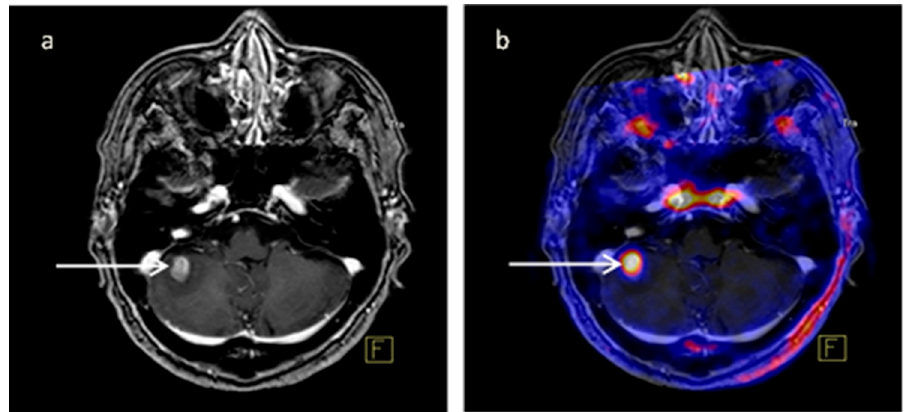
Figure 3. MRI-T1 post gadolinium sequence ( a ) and fused PET/MRI ( b ) images. Cerebellar metastatic lesion (arrows) 4 months after radiotherapy. Primary cancer site is breast. SUVmax, T/B, SUVpeak 2.62, 13.1 and 1.54 respectively. PV50% and PV75% 1.302 and 0,401 respectively.